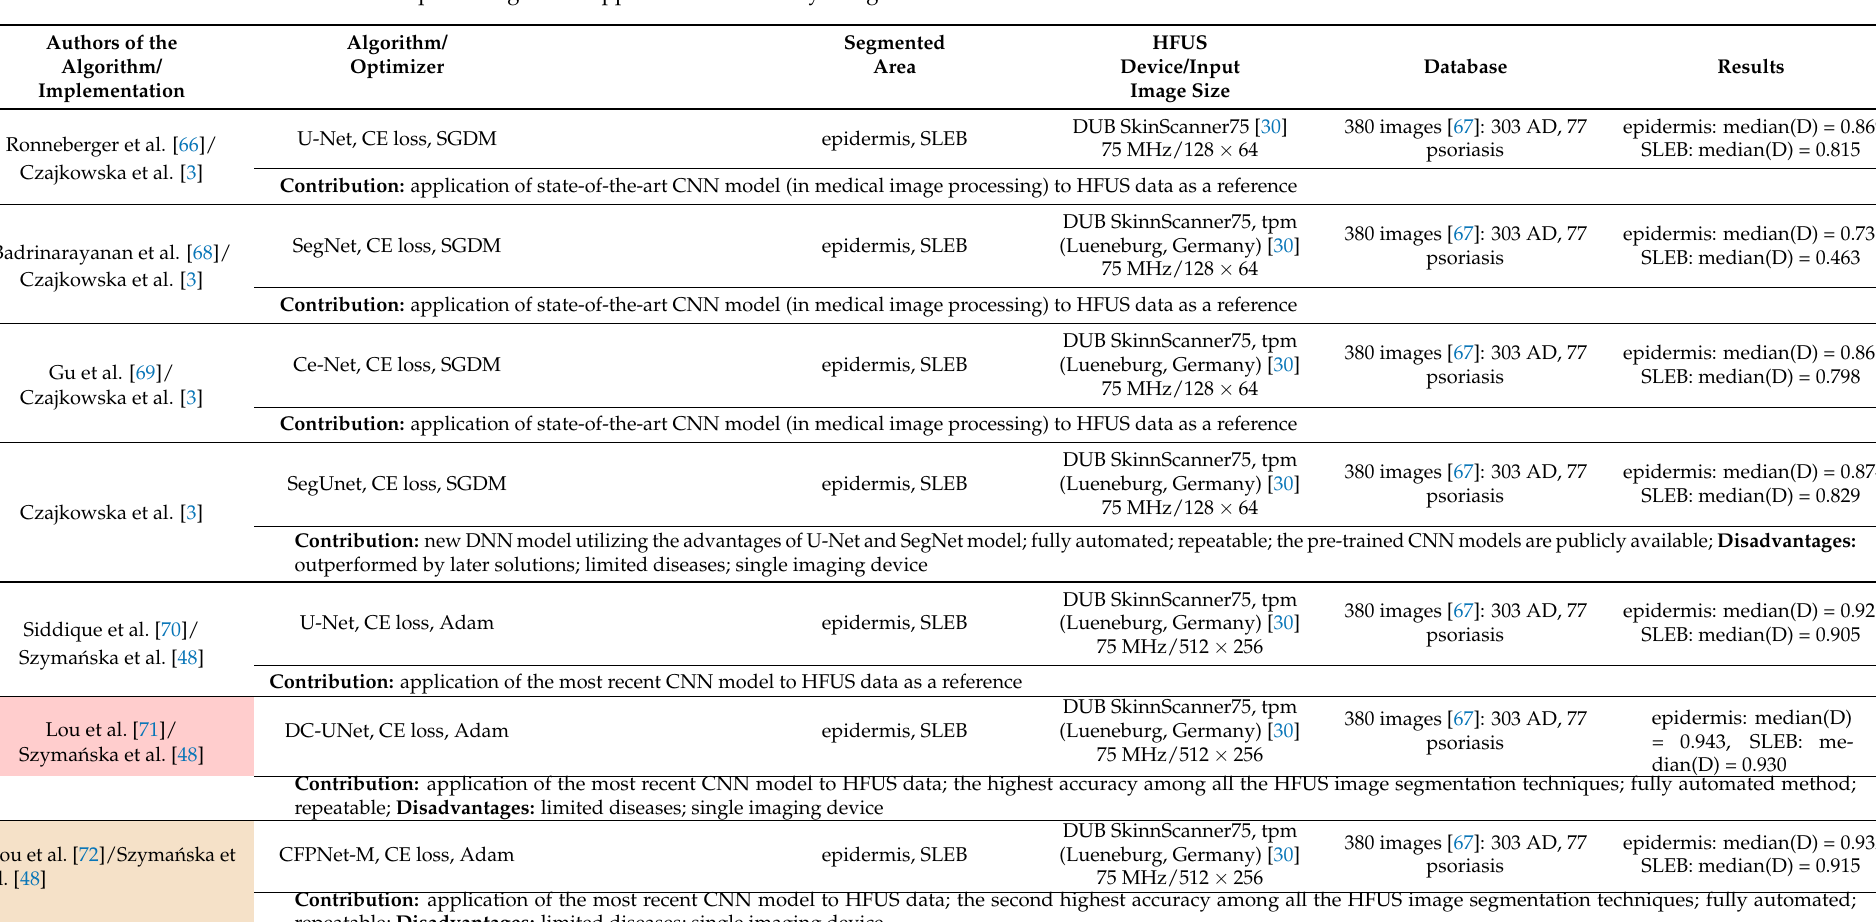
Table 5. Deep learning-based approaches for skin layer segmentation in